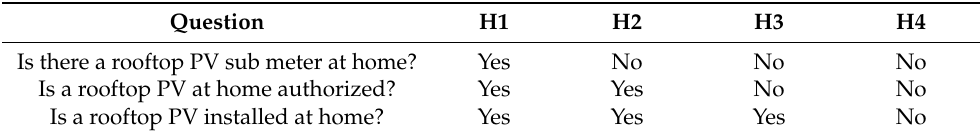
Table 2. Four home group for rooftop PV.